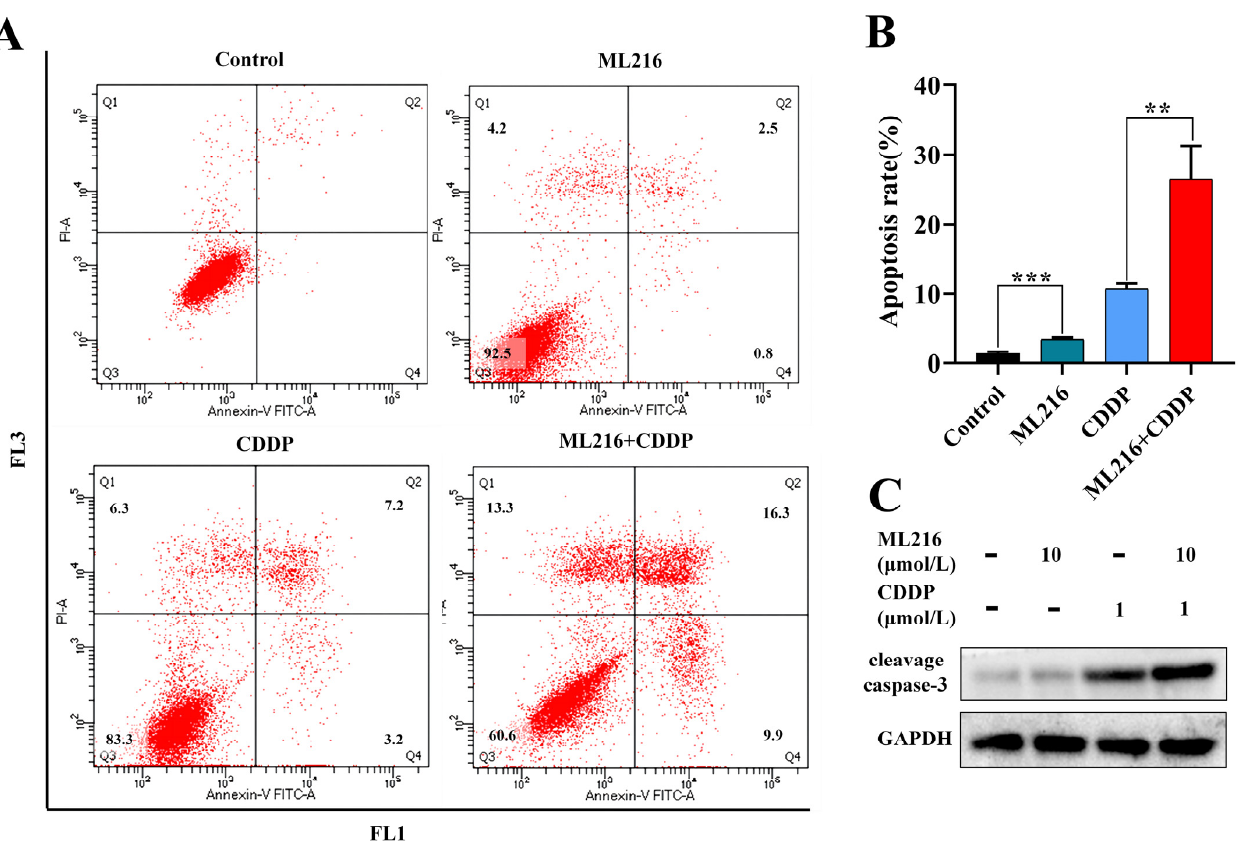
Figure 4. ML216 hypersensitizes CDDP-induced apoptosis in PC3 cells. ( A ) Cell apoptosis